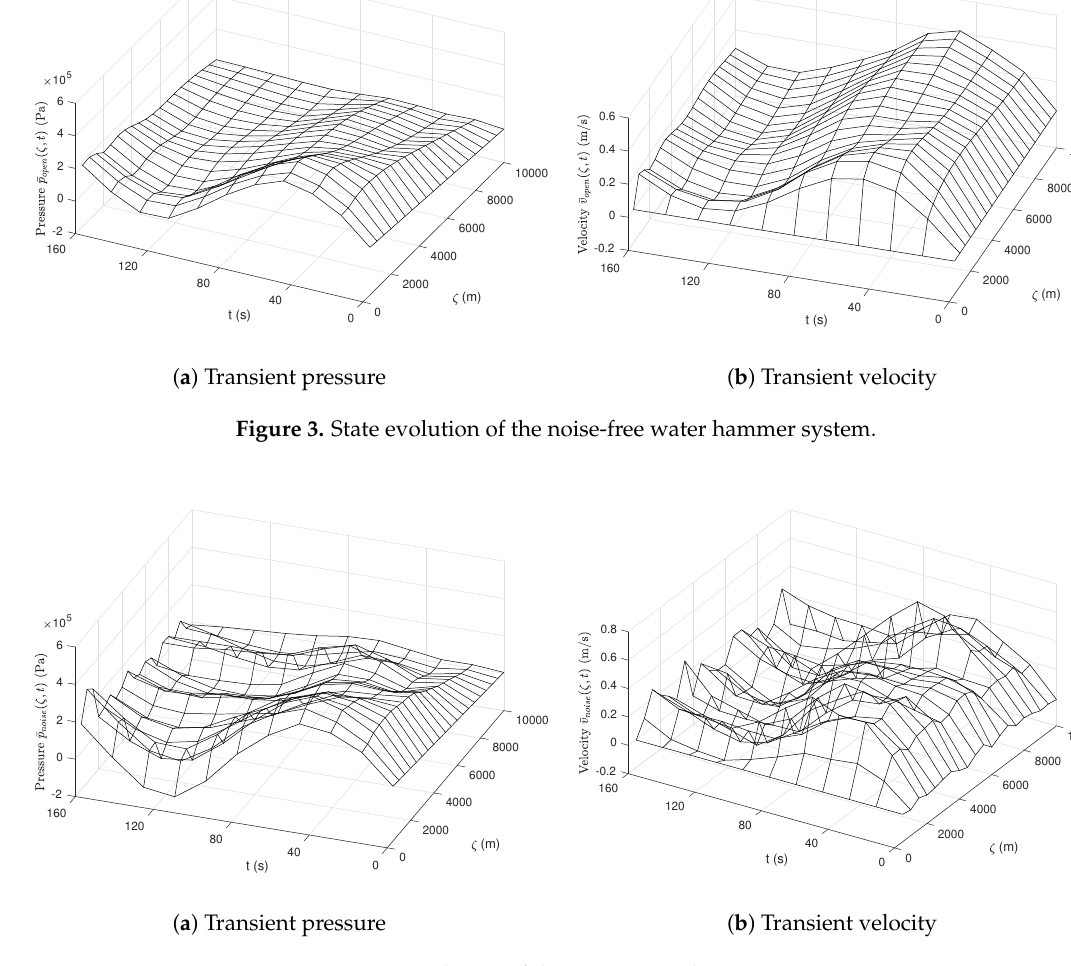
Figure 4. State evolution of the noisy water hammer